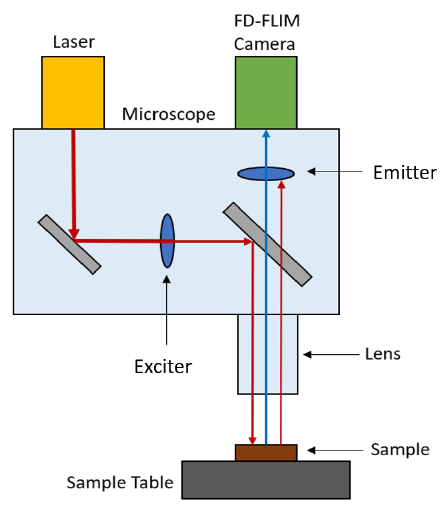
Figure 4. Illustration of the experimental setup used for the exper- iments including a laser, a microscope, optical filters and an FD- FLIM camera